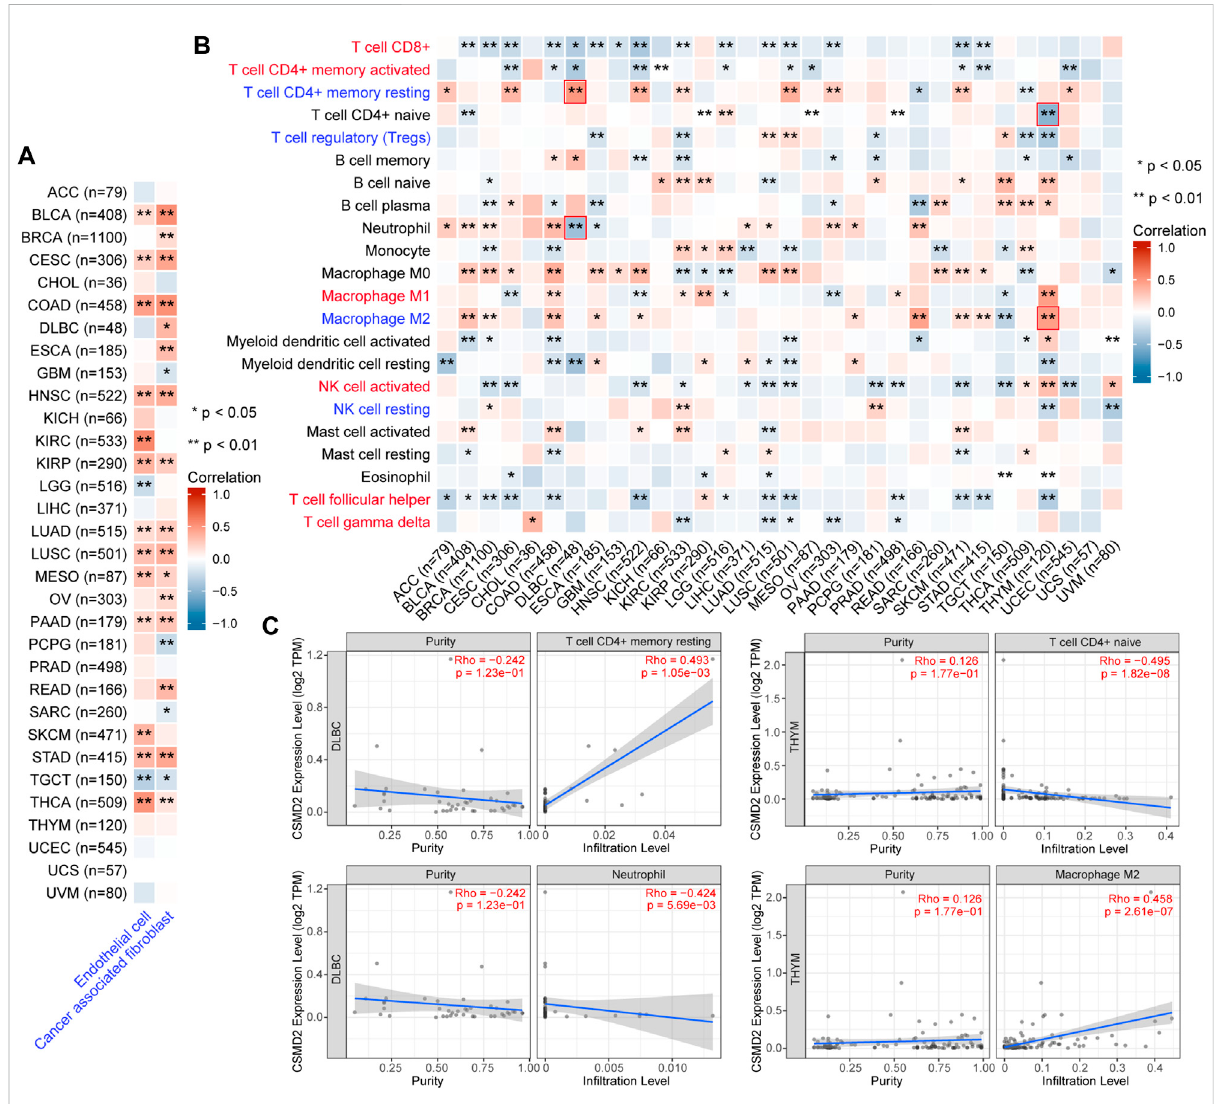
FIGURE 7 Correlation analysis between CSMD2 expression and immune in fi ltration in the tumor microenvironment. Heat maps display a correlation between CSMD2 expression level and in fi ltration level of (A) cancer-associated fi broblasts and endothelial cells based on XCELL, and (B) 22 immune cells based on CIBERSORT in pan-cancer. Anti-tumor immune cells are highlighted in red, and immune evasion- associated cells are highlighted in blue. (C) The scatter plots show the top two strongest positive and negative correlations marked in red boxes in (B) . Correlations are depicted with the partial Spearman ’ s correlation and statistical signi fi cance based on